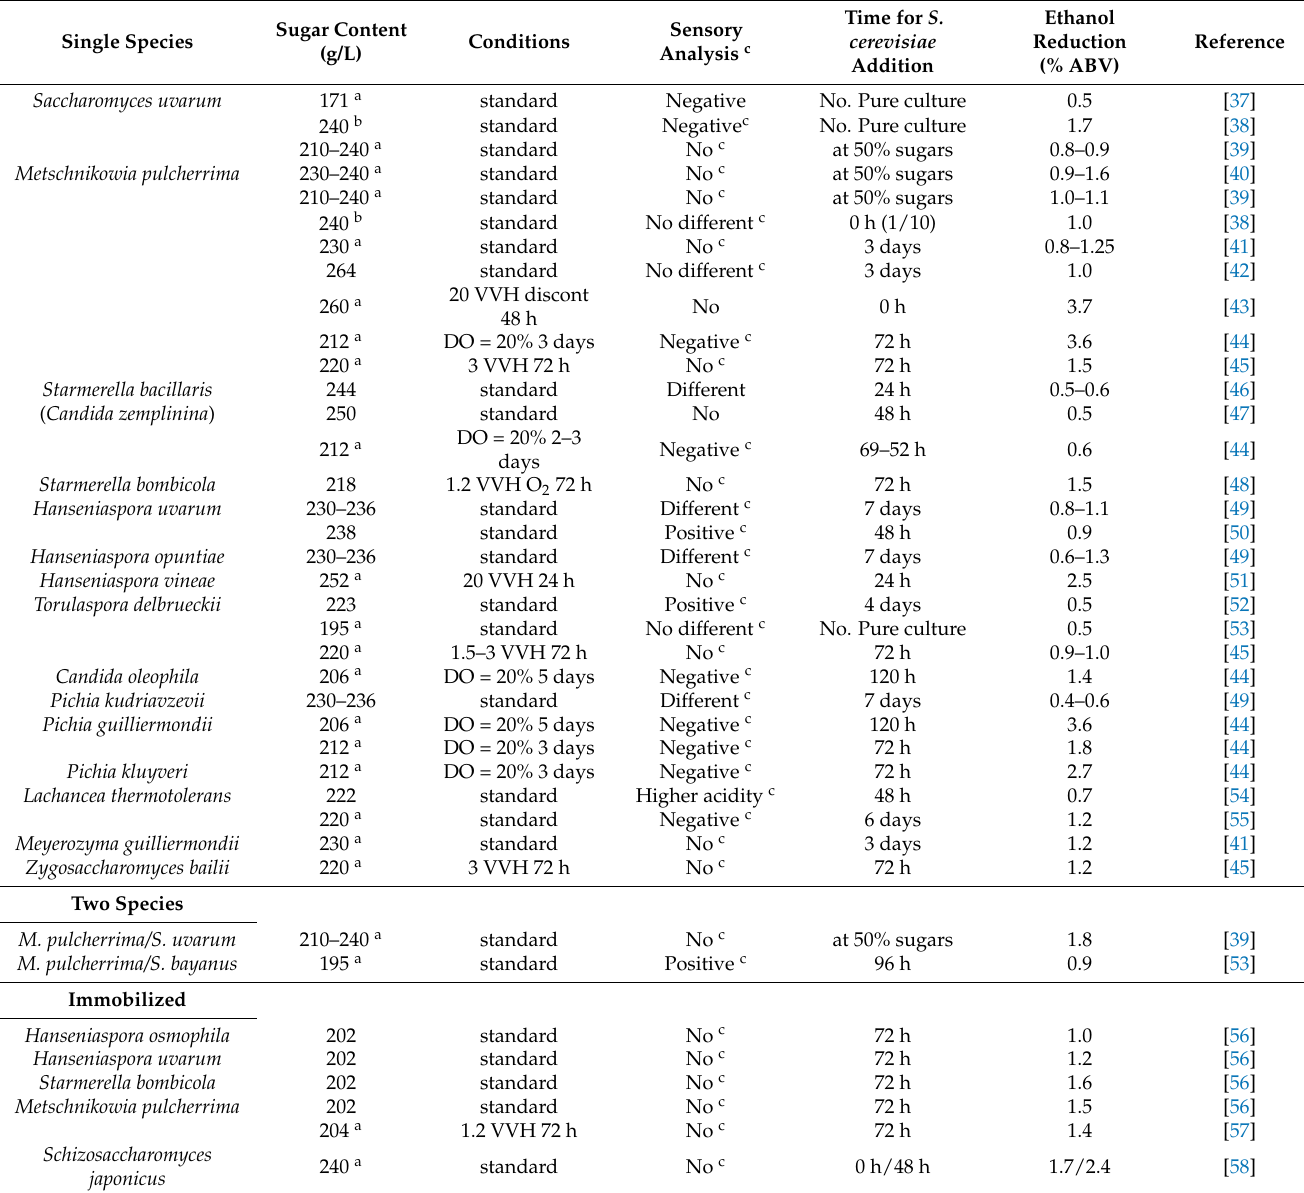
Table 1. Fermentation conditions and the results obtained for alcohol level reduction using strains of different non- Saccharomyces wine yeast species on natural grape